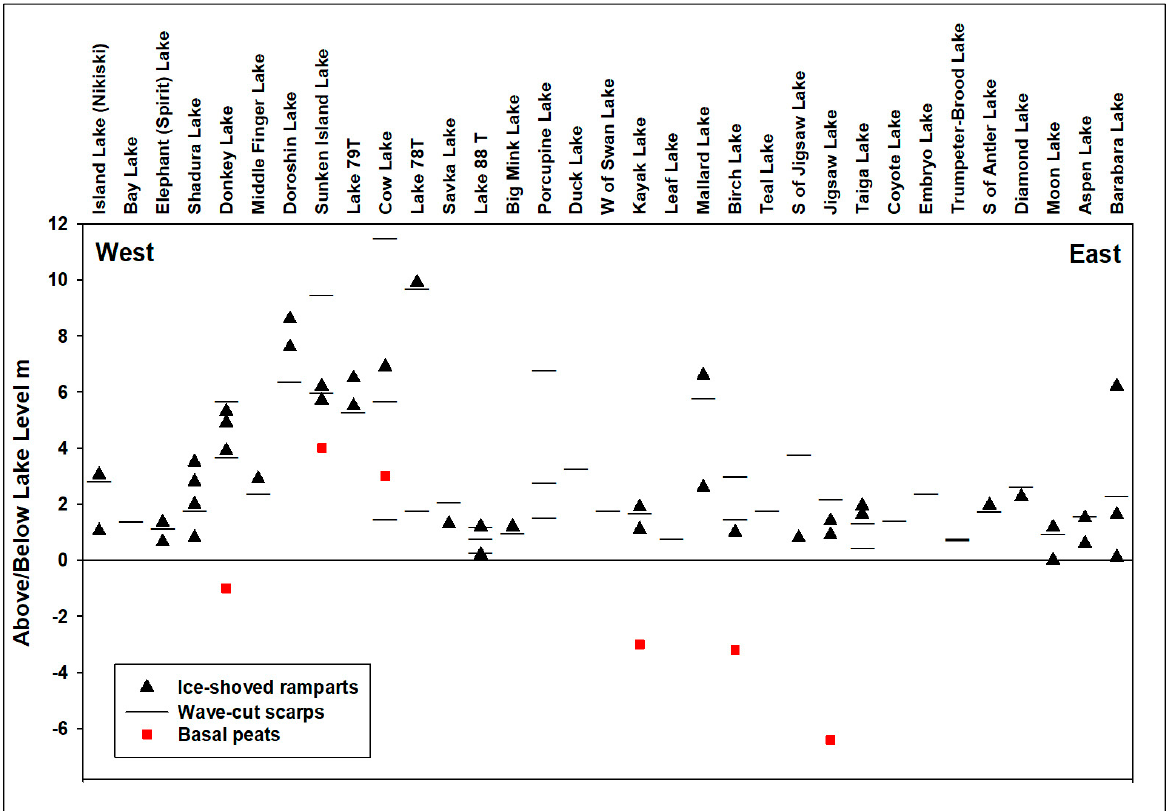
Figure 4. Variability of closed-basin lakes on the kettle moraine topography of the Kenai Lowland. Horizontal bars show positions of wave-cut scarps above modern (2008) lake levels; black triangles show ice-shoved rampart (ISR) positions. Red squares show basal terrestrial peat depths of satellite fens. Lakes are arranged from west to east. Factors such as lake size, landscape position, orientation to prevailing winds, beach slope profile, and the extent of satellite fens all contribute the exhibited variability.